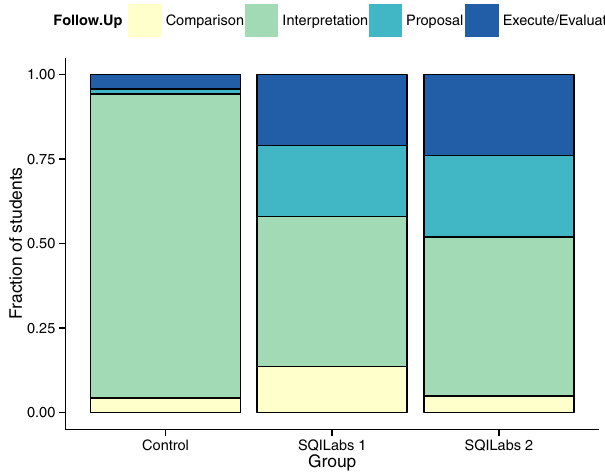
FIG. 3. The distribution of how students followed-up on making comparisons(asafractionofstudentswhomadecomparisons).Each level builds on the next, such that the fraction of students shaded as “ comparison ” only made comparisons, students shaded as “ inter- pretation ” both made and interpreted their comparisons, and so on.